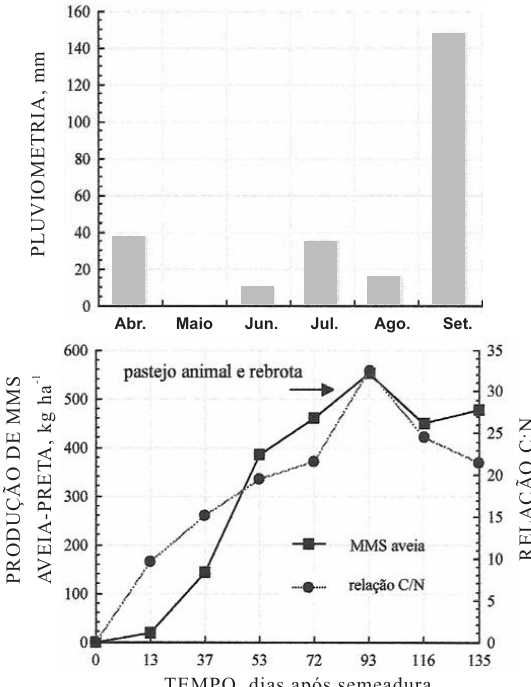
Figura 1. Precipitação pluvial mensal, marcha de produção de massa de matéria seca (MMS) e relação C:N da parte aérea de aveia-preta nos meses de outono-inverno de 2000, como cultura antecessora ao